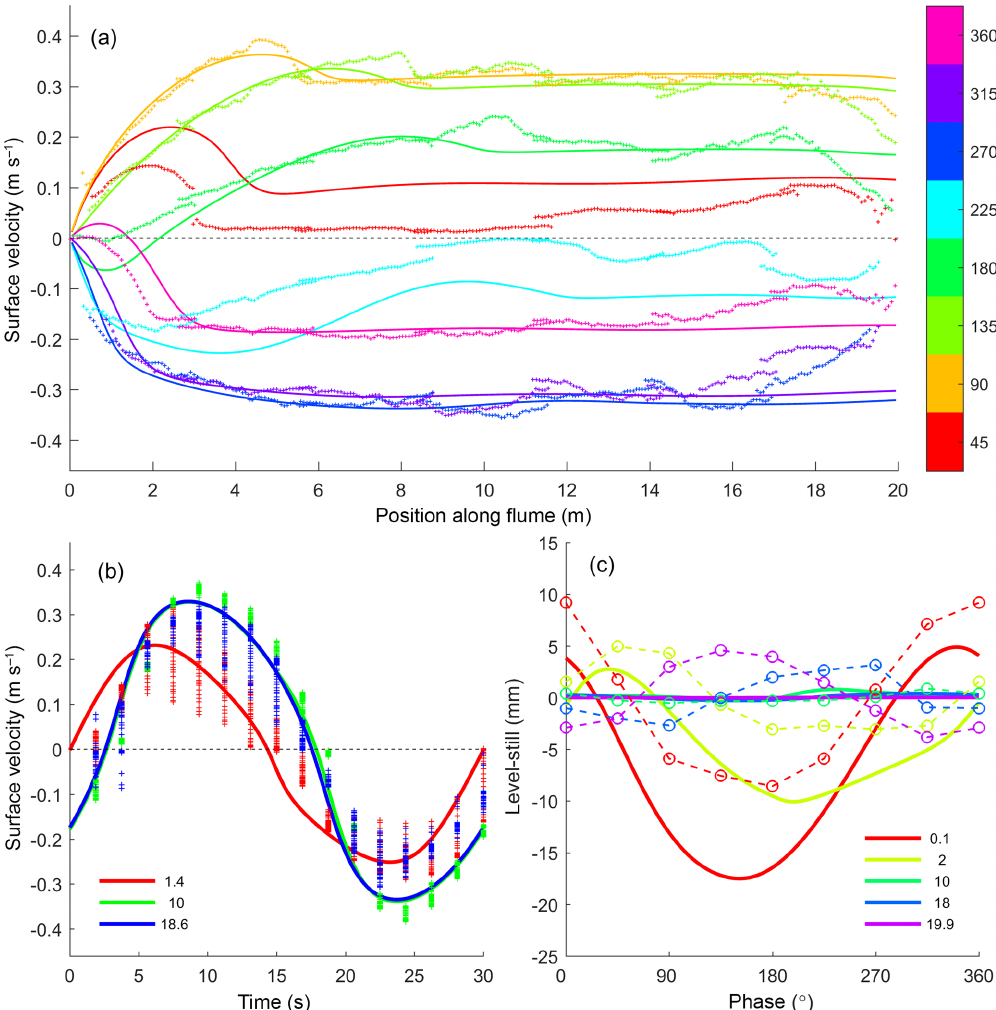
Figure 9. Flow data from PIV and modelled flow with 30 s period tilting at 0.009mm − 1 slope amplitude with upstream boundary closed. (a) Flow velocity at the water surface along the flume for selected phases of the tidal cycle. (b) Flow velocity at the water surface in one tidal cycle for selected positions along the flume measured from x = 0m, indicated in the legend. (c) Water level as a function of phase in the tidal cycle for selected positions along the flume. Measured water levels have correct amplitude and phase but possibly erroneous vertical offsets. Data are plotted as symbols and model results are plotted as drawn